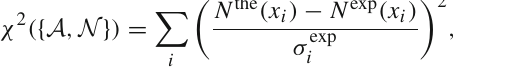
factors and amplitudes are shown in Table 1, the result on the χ 2 / d . o . f . is also collected therein. In order to describe the experimental measurement, the theoretical line shapes have been convoluted with the detector